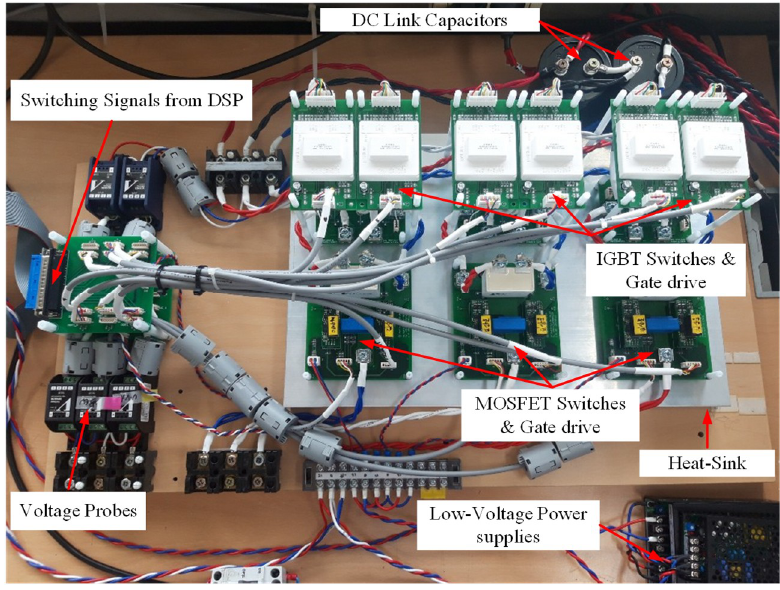
Figure 12. Experimental setup circuit for 15kW HANPC inverter.